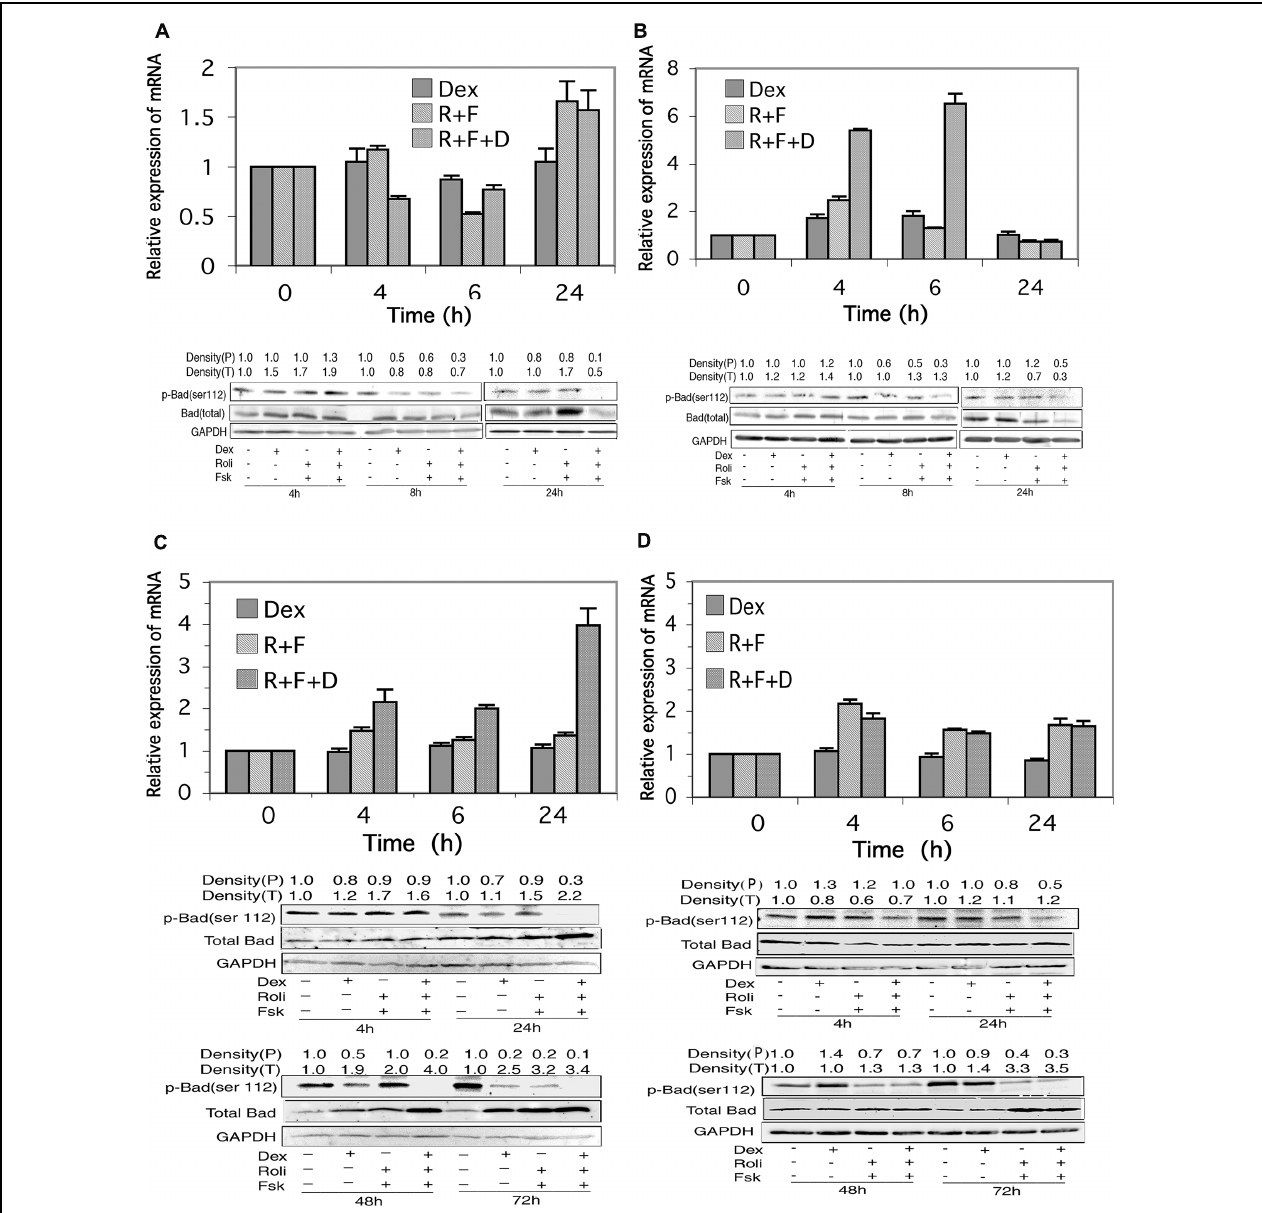
FIGURE 6 | Bad expression in CEM and MM.1 cells. Top panels: quantitative real-time PCR analysis of Bad mRNA at different times after treatment with 1 µ M dexamethasone (Dex), 10 µ M rolipram plus 10 µ M forskolin (R + F), or 1 µ M dexamethasone plus 10 µ M rolipram plus 10 µ M forskolin (R + F + D) as indicated. Data represent the mean ± SD of at least two independent experiments assayed in triplicate, shown as fold change relative to control. Bottom panels: Western blot analysis of expression of total Bad and p-Bad (ser112) protein. Cells were treated at different times with dexamethasone and/or rolipram and forskolin as indicated, and Bad protein expression was determined by immunoblots of whole cell lysates. An equal amount of protein (20 µ g) was loaded per lane. Densities of phosphorylated Bad (P) and total Bad (T) are given at the top of the Western blot panels, calculated as described in Section “Materials and Methods.” Data shown represents one of at least two independent experiments with similar results. (A) CEM-S2 cells; (B) CEM-R8 cells; (C) MM.1S cells, and (D) MM.1R cells.